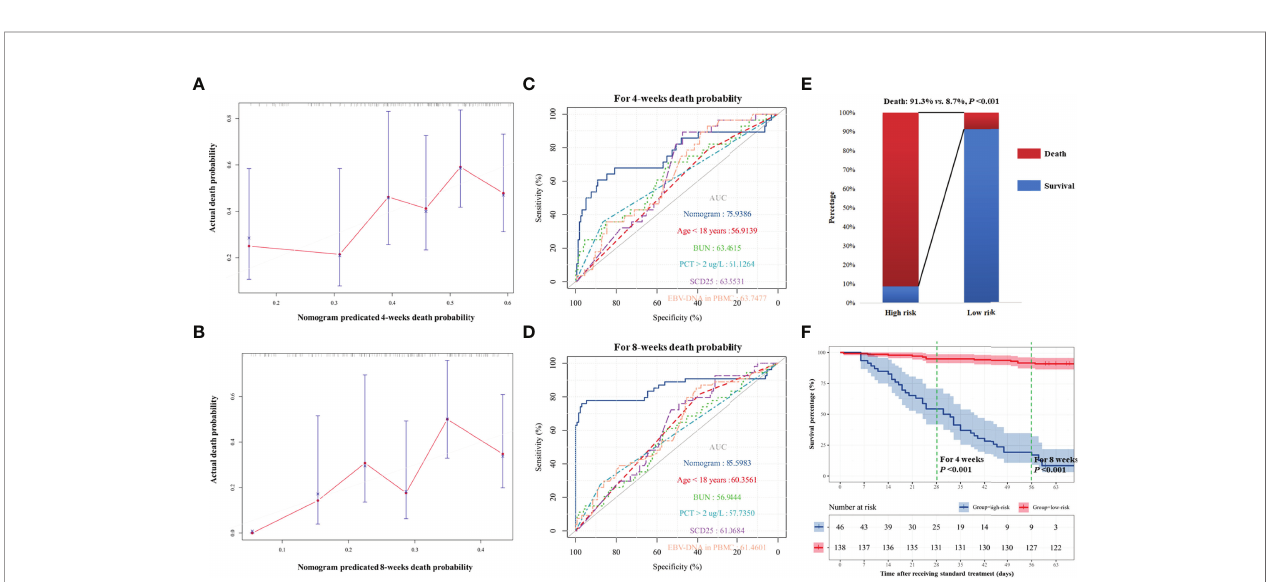
FIGURE 3 | The predicting accuracy of nomogram for death in induction therapy. (A, B) For death within 4 and 8 weeks, the nomogram has good consistency with actual death. (C, D) The predictive accuracy of nomogram and other risk factors for 4-week death and 8-week death. (E) The proportion of death in the high-risk group and the low-risk group. The difference was signi fi cant (91.3% vs. 8.7%, P < 0.001). (F) The survival analysis showed that high-risk patients had higher risk of death. Bun, blood urea nitrogen; PCT, procalcitonin; EBV, Epstein – Barr virus; DNA, deoxyribonucleic acid; PBMC, peripheral blood mononuclear